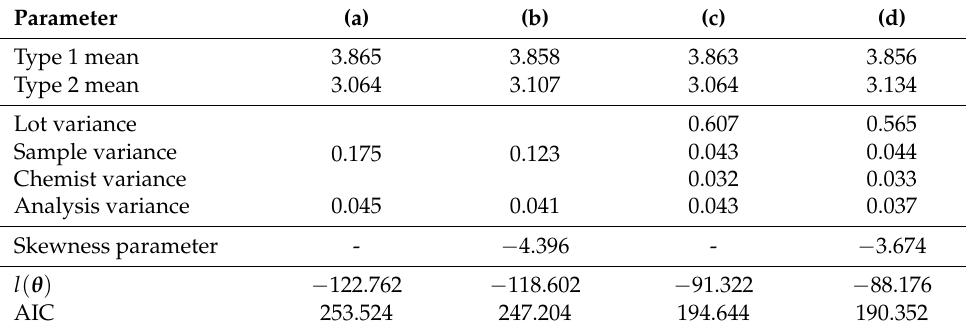
Table 5. Metallic oxide summary results for four